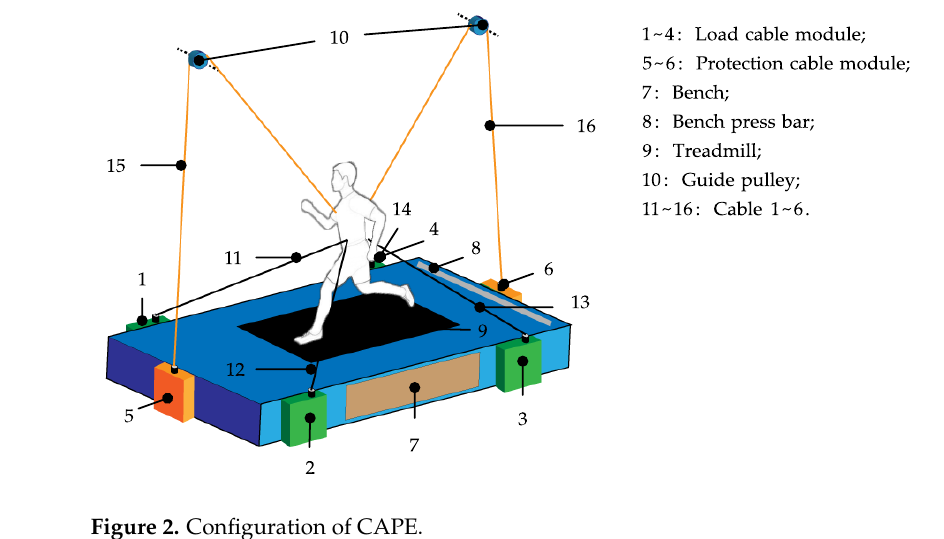
Figure 2. Configuration of CAPE.